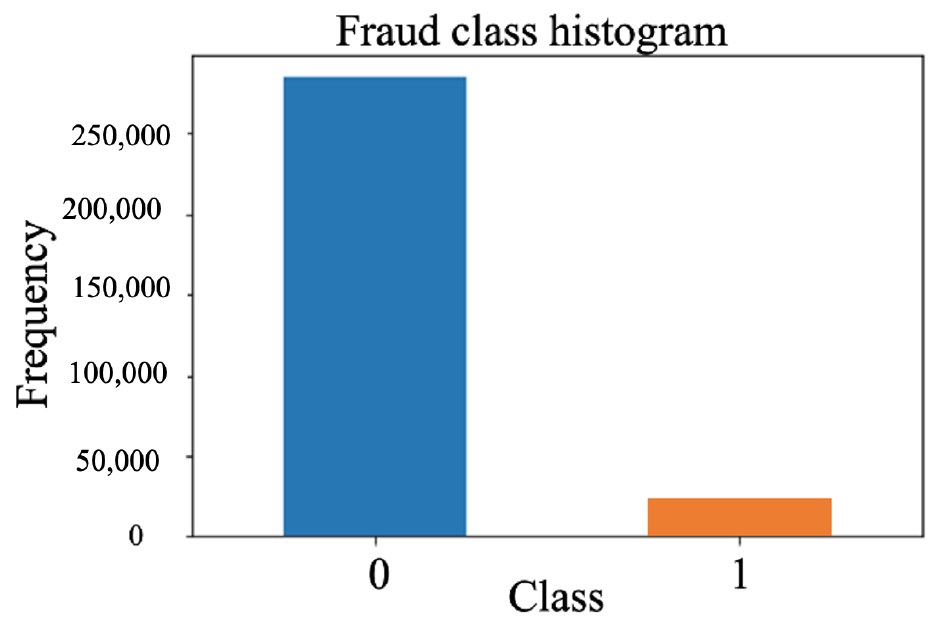
As shown in Figure 2, this CCF dataset is highly imbalanced so we can define the positive and negative classes as the minority and the majority classes. It is true that the imbalanced ratio (IR) is the most prevalently employed measure, which illustrates the imbalanced extent of a dataset.